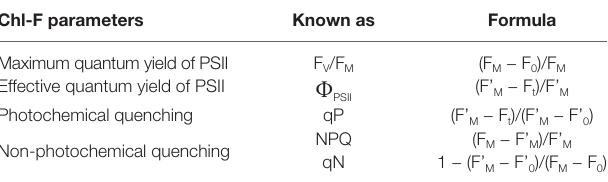
TABLE 1 | Chl-F parameters of common use in biotic stress detection. For further details, see Rohá č ek and Barták (1999), Maxwell and Johnson (2000), and Murchie and Lawson